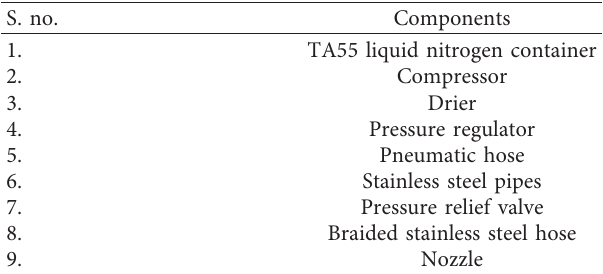
Table 1: Cryogenic broaching setup components. S.